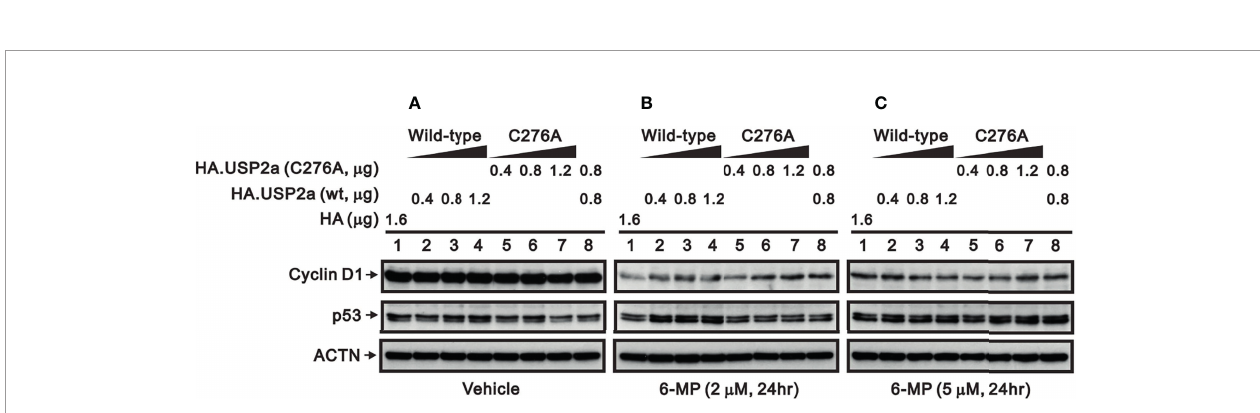
FIGURE 8 | Effect of 6-MP on levels of USP2a target proteins in A253 cells expressing wild-type USP2a or its C276A mutant. Cells were transiently transfected for 16 h with the indicated amount of pSG5.HA.USP2a (wild-type) or pSG5.HA.USP2a (C276A) and then treated for 24 h with (A) vehicle, (B) 2 m M 6-MP, or (C) 5 m M 6-MP. Cell lysates were the subjected to Western blotting analysis with antibodies against cyclin D1 and p53. ACTN is a loading